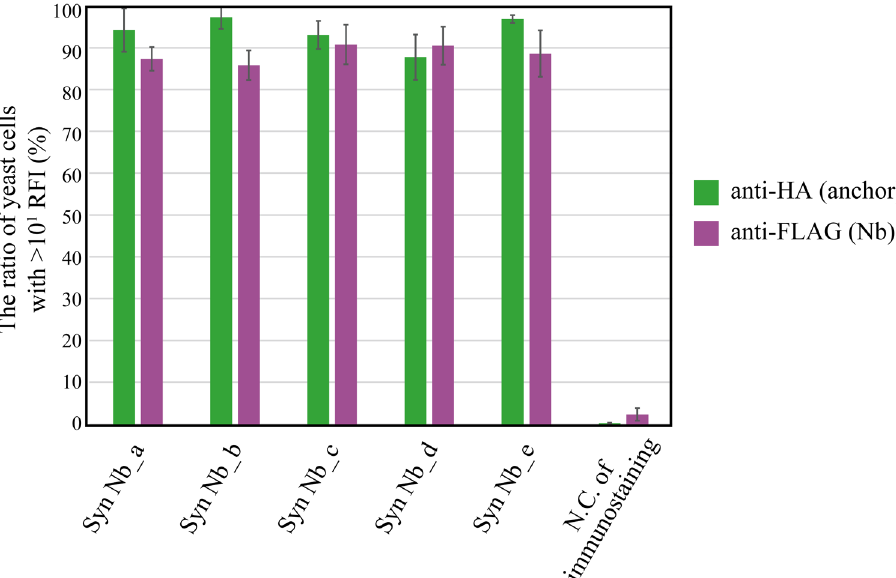
Figure 3. Yeast cell surface display of various nanobodies derived from a synthetic nanobody library. Five nanobody-encoding nucleotide sequences were isolated from the synthetic nanobody library (see “Methods”) and cloned into pRS415 with a FLAG tag and a SpyTag. The multiple alignments of the five nanobodies were also performed (Supplementary Information Fig. S4). The plasmids were transformed into the BY4741 strain harbouring a plasmid encoding the 649-stalk anchor protein fused with an HA tag. The negative control strain, used to indicate the nonspecific absorption during immunostaining for flow cytometry, did not contain an HA nor a FLAG tag. Each sample was stained using mouse anti-HA tag antibody and AF488-conjugated anti-mouse antibody, or mouse anti-FLAG tag antibody and AF647-conjugated anti-mouse antibody. The data of three independent experiments were represented as means ± standard deviations. Syn Nb nanobody derived from the synthetic library, N.C. negative control, RFI relative fluorescence intensity. This figure was created using Illustrator CS2 (https:// www. adobe.